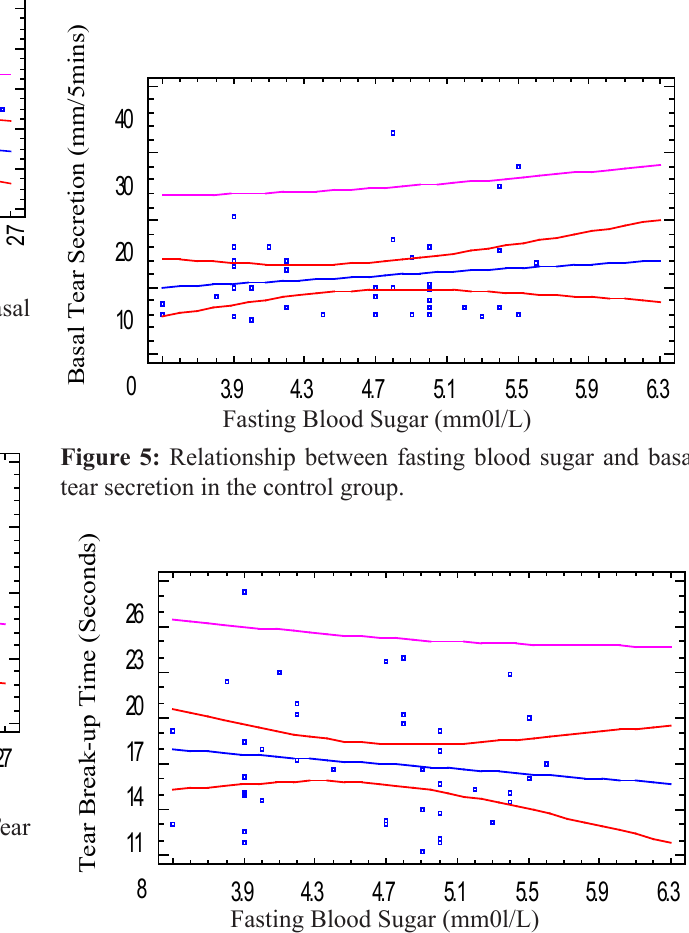
Figure 6 : Relationship between fasting blood sugar and tear break up time in the control